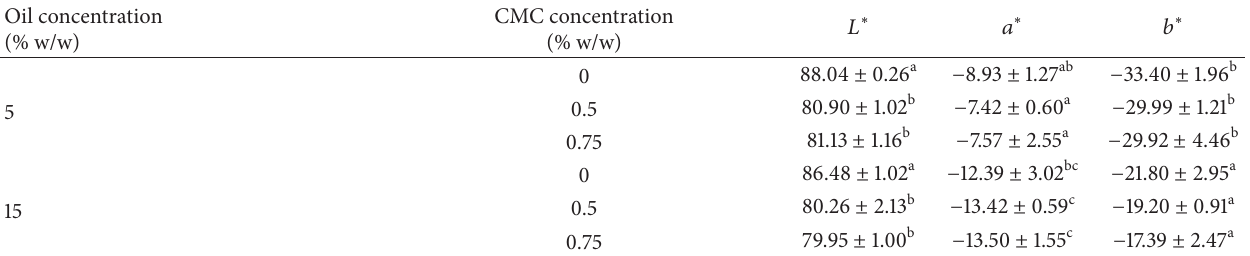
Table 6: Mean values and significant differences of lightness ( 𝐿 ∗ ), red-green component ( 𝑎 ∗ ), and yellow-blue component ( 𝑏 ∗ ) for O/W nanoemulsions based on olive oil with different CMC concentrations.